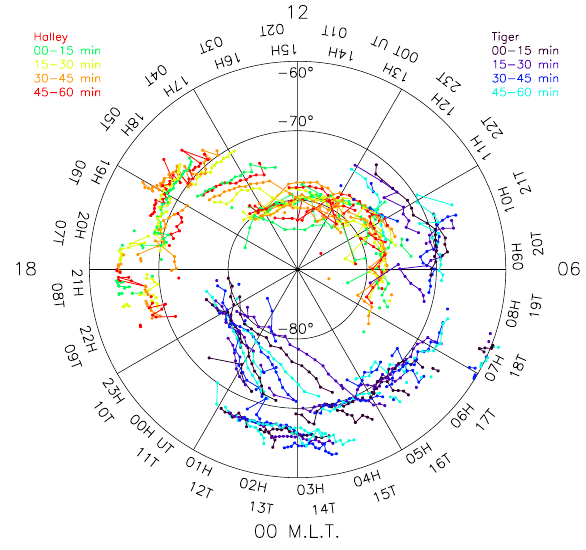
Fig. 8. SWBs for Halley and TIGER radar full scans during 08:00 to 22:00 UT on 1 April 2000. The results have been mapped to co-ordinates consisting of MLT and AACGM latitude. The SWBs have been averaged over 15-min intervals, and are color coded as follows: Halley 00–15min (green), 15–30min (yellow), 30– 45min (orange), and 45–60min (red) past the hour, and TIGER 00–15min (black), 15–30min (purple), 30–45min (blue), and 45– 60min (aqua) past the